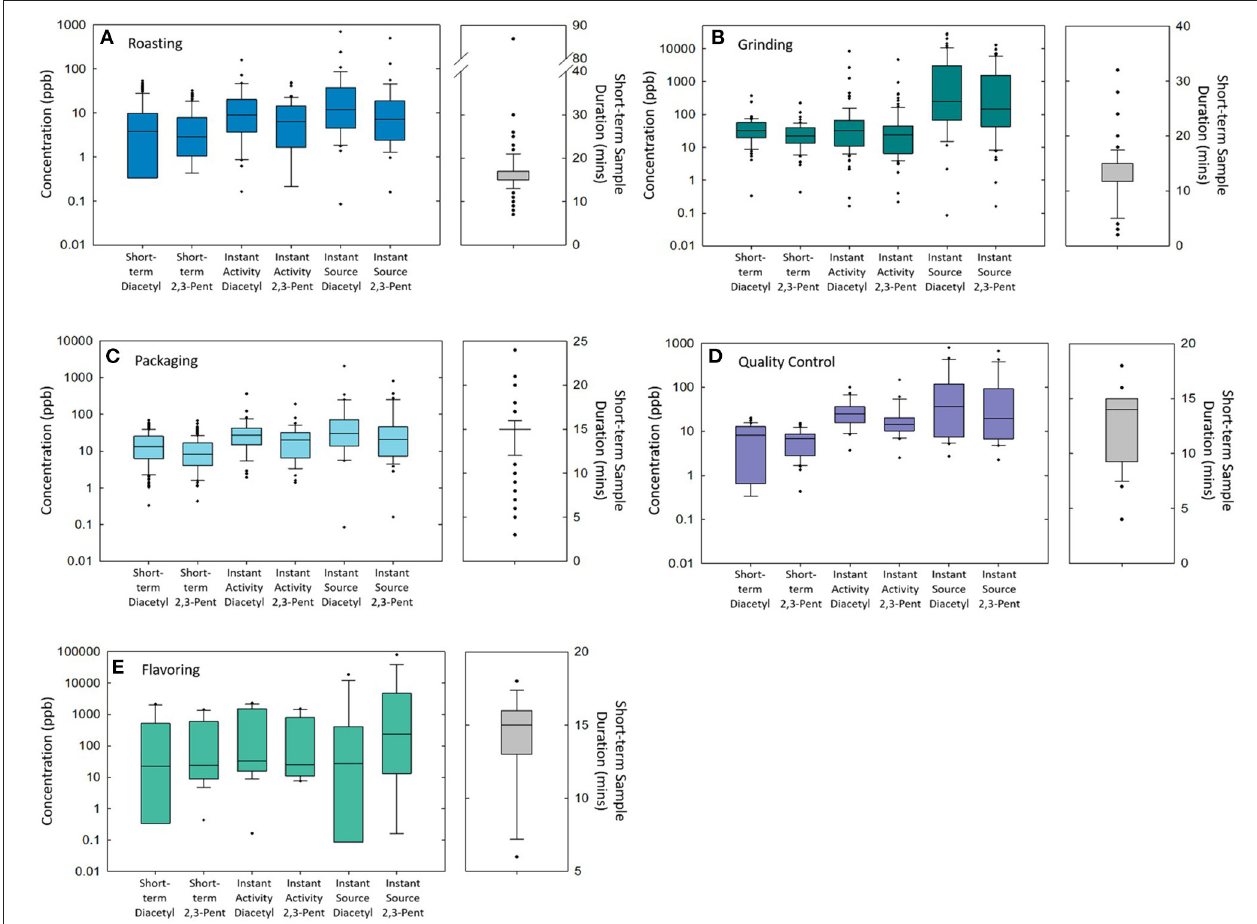
FIGURE 1 | A panel of box plots of diacetyl and 2,3-pentanedione concentrations measured in short-term task-based, instantaneous activity, and instantaneous source samples and short-term task-based sample durations during roasting tasks (A) , grinding tasks (B) , packaging tasks (C) , QC tasks (D) , and flavoring tasks (E) .